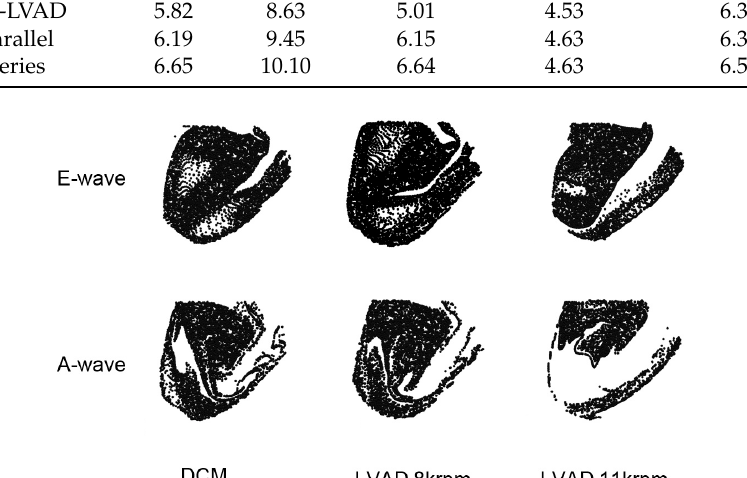
Figure 5. Lagrangian particle analysis reflects the LCS structures identified from the FTLE analysis, illustrating how the altered filling dynamics affects transport through the LV.